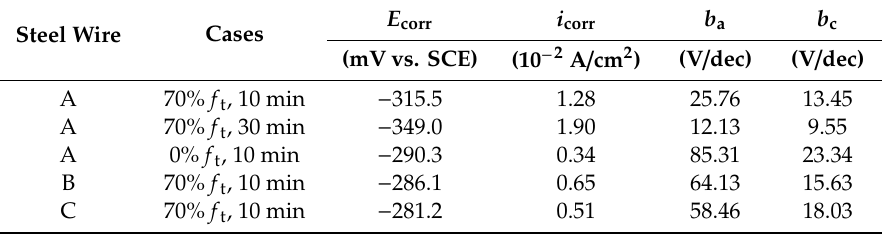
Table 3. Electrochemical parameters of polarization curves of prestressed steel